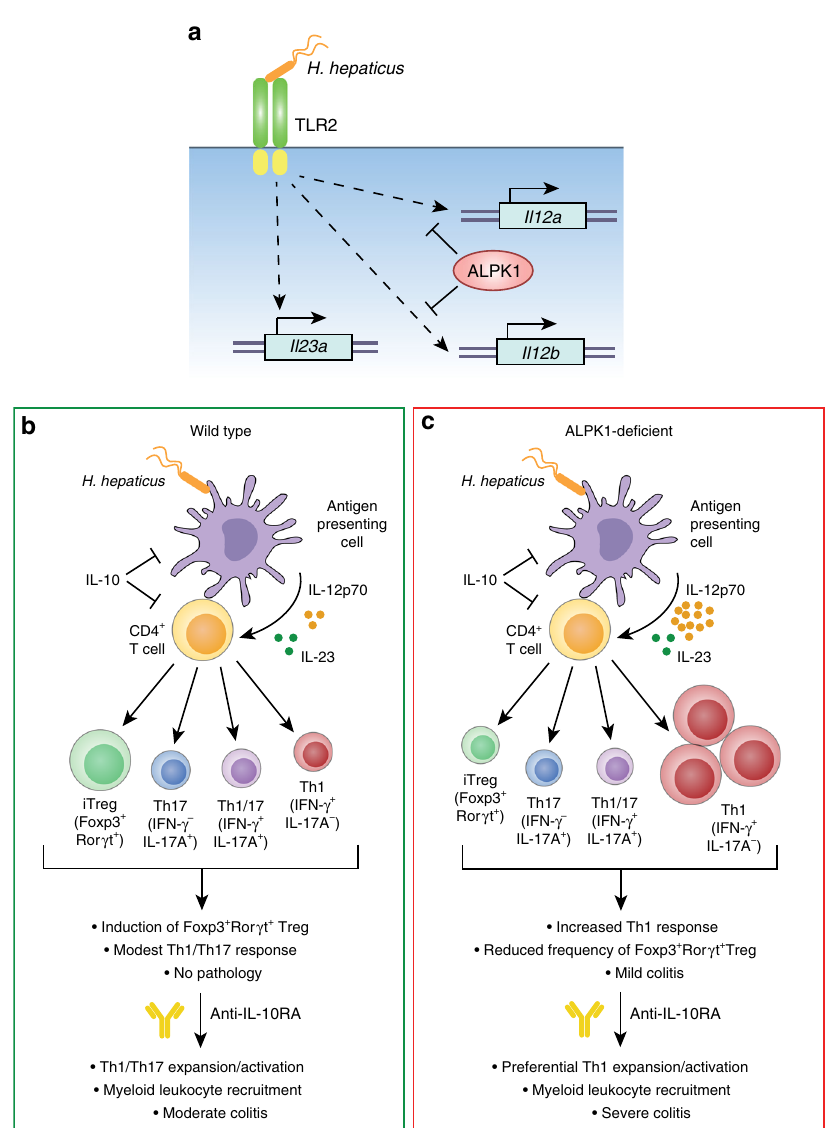
Fig. 7 Working model for the role of Alpk1 in controlling gut immune homoeostasis. a TLR2 signaling in response to Helicobacter hepaticus induces expression of Il12a , Il12b , and Il23a in antigen presenting cells (APCs). Alpk1 selectively inhibits expression of Il12a and Il12b , but does not signi fi cantly restrain Il23a expression. b In wild-type APCs, control of Il12a and Il12b expression by Alpk1 results in balanced and modest secretion of IL-12p70 and IL-23 in response to H. hepaticus . IL-10 acts independently to further control release of pro-in fl ammatory cytokines. This results in activation of FOXP3 + ROR γ t + inducible Tregs and modest induction of Th1 and Th17 effector CD4 + T cells, which does not cause detectable pathology or signi fi cant alterations in effector cytokine production in the gut. Additional blockade of IL-10 signaling using an anti-IL10R antibody results in robust activation of a mixed population of Th17 and Th1 effector T cells, recruitment and activation of myeloid cells, and moderate colitis. c In Alpk1-de fi cient mice, H. hepaticus stimulates potent production of IL-12, which promotes polarized activation of pro-in fl ammatory Th1 effector T cells at the expense of Tregs and Th17 cells, and mild